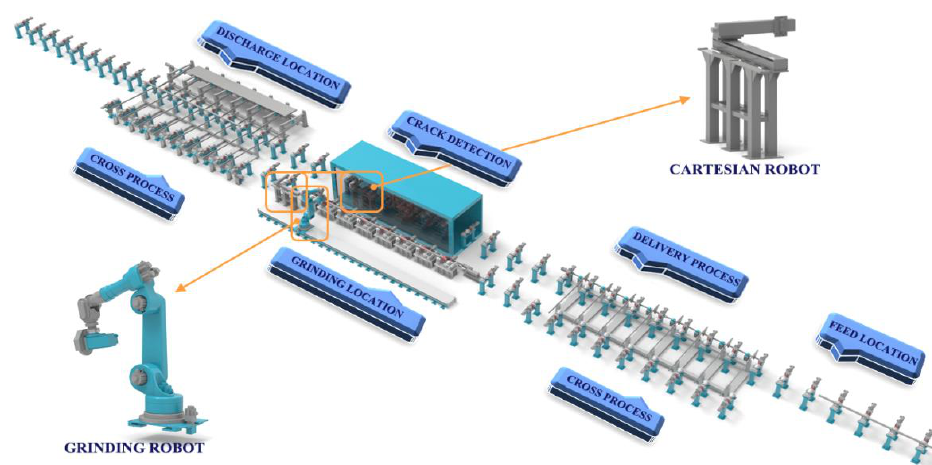
Figure 1. The steel bar finishing process.